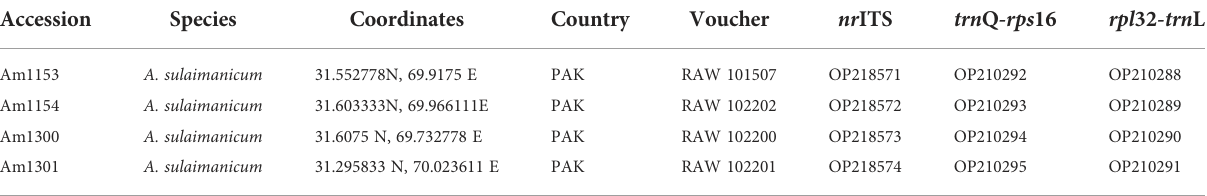
TABLE 1 Origin, source, and GenBank accession numbers of Allium sulaimanicum used for phylogenetic